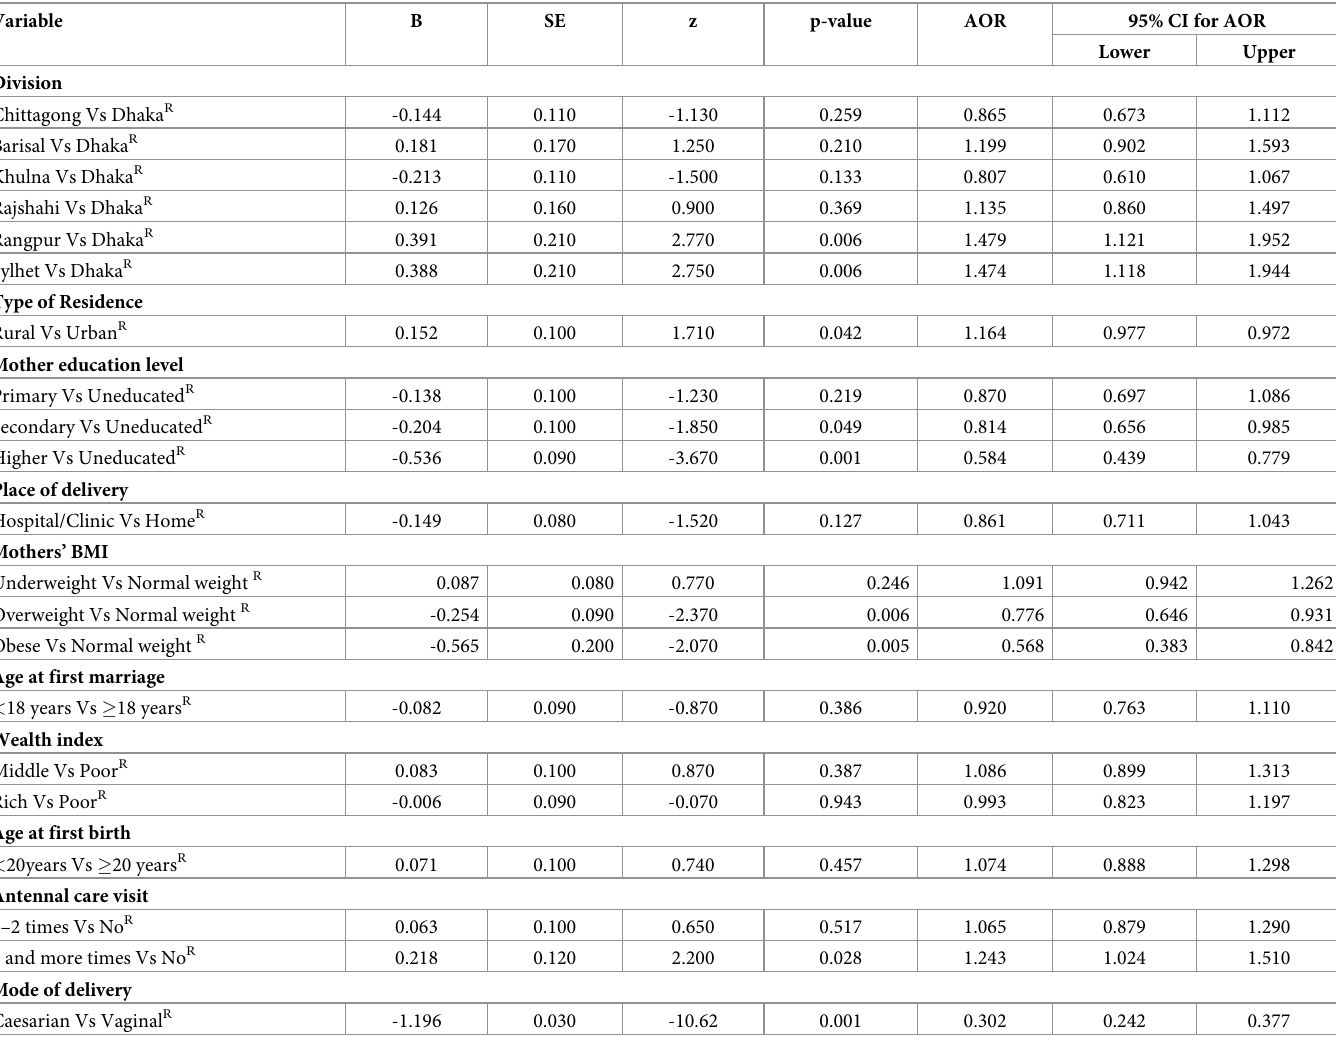
Table 2. Effect of socio-economic and demographic factors on early initiation of breastfeeding among non-pregnant mothers in